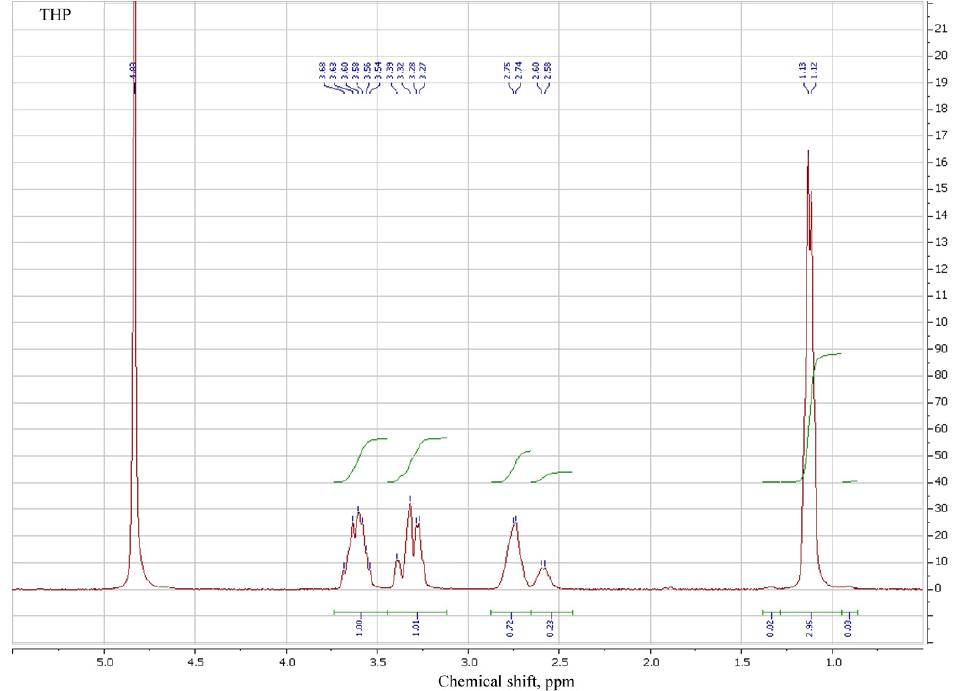
Polymers 2022 , 13 , x FOR PEER REVIEW Figure 1. NMR 1 H spectrum of THP in deuterated water. Figure 1. NMR 1 H spectrum of THP in deuterated water.